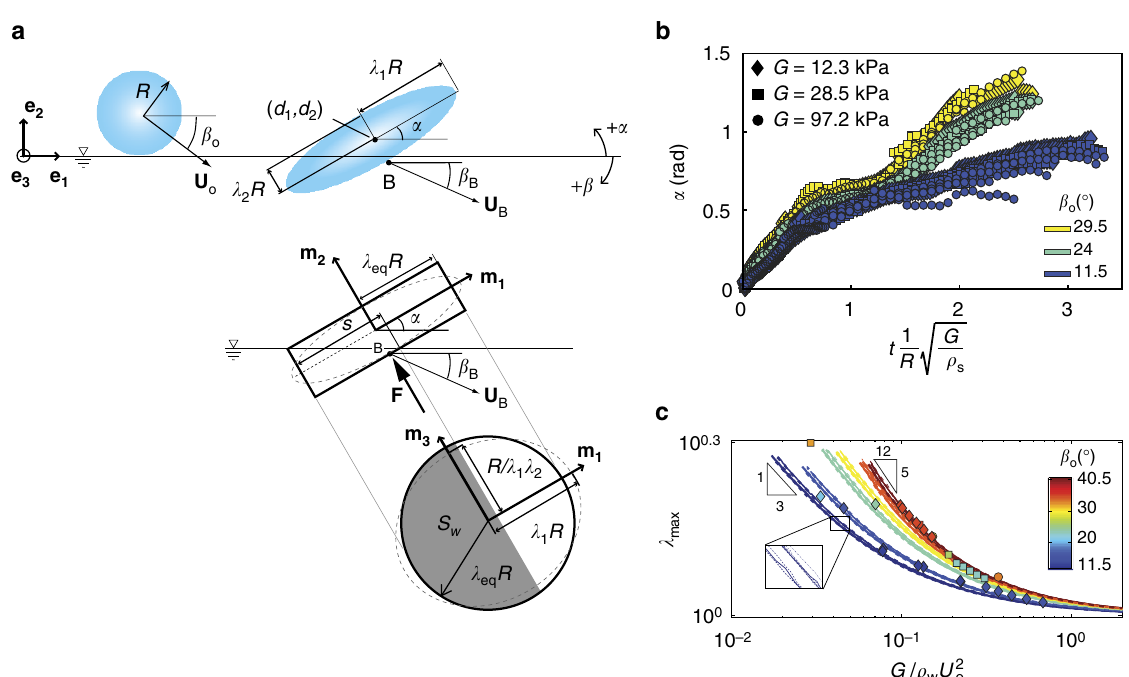
Figure 3 | Description of sphere deformation during impact. ( a ) Our analytical model assumes the deformed sphere takes an ellipsoidal shape with principal stretches l 1 , l 2 and l 3 ¼ 1/ l 1 l 2 aligned with the body-fixed { m 1 , m 2 , m 3 } coordinates, respectively. The { m 1 , m 2 , m 3 } coordinate system is inclined at attack angle a relative to the free-surface and has its origin at the sphere’s centre of mass ( d 1 , d 2 ). To model the hydrodynamic force F , we represent the sphere as a circular disk with radius l eq R and assume that F acts at the point B on the water-contacting face, which moves with velocity described by U B and b B . ( b ) The attack angle a is measured from simulations using our Abaqus numerical model for spheres undergoing mode 1 (cid:2) deformations, with properties R ¼ 25.4mm, r * ¼ 1.05 and varying shear modulus; sample a measurements are shown in Fig. 4b–d. For each b o , the attack angle is collapsed by the ffiffiffiffi q G , which is proportional to the speed of mode 1 (cid:2) elastic waves propagating through the characteristic distance R . These attack dimensionless time 1 R r s angle data are fed into our analytical model (see Methods section). ( c ) The simulations also show the dependence of l max on G = r w U 2 maximum value of l eq achieved during impact (individual marker shapes same as for ( b )). The numerical results agree with predictions from our analytical model (the zoomed region shows the nine different line styles corresponding to analytical results for nine different spheres: dashed lines R ¼ 20.1mm; solid lines R ¼ 26.2mm; dash-dot lines R ¼ 48.8 mm; line width indicates G : thin G ¼ 12.3kPa; middle G ¼ 28.5kPa; and thick G ¼ 97.2kPa). In the limit of small G , we find l max / G = r w U 2 o